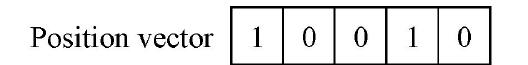
Figure 6. The final position vector .